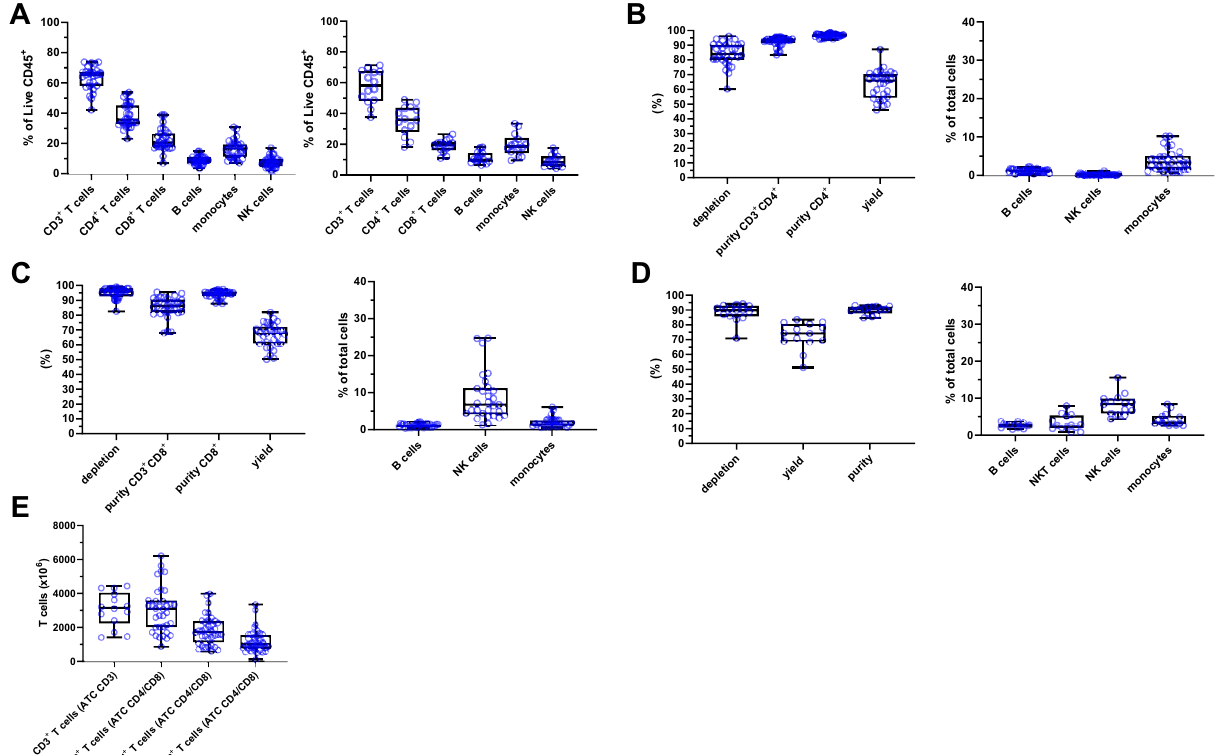
Figure 3. Characterization of ATC T cell purification using leukapheresis as starting material. ( A ) Lymphocyte cell subset composition of starting material. Graphs present data from 27 washed healthy apheresis donors (left panel) and washed cryopreserved apheresis healthy material from 14 donors (right panel). Boxes represent mean ± SD. ( B ) Selection data for CD4 target cell fraction in the ATC CD4/CD8 selection process. Graphs show CD4 + T cell depletion efficiency, purity for CD4 + T cell target fraction as well as CD4 + on-target fraction, CD4 T cell yield and on-target (monocytes) and off-target impurities (B cells, NK cells) of 27 individual purifications. Boxes represent mean ± SD. ( C ) Selection data for CD8 target cell fraction in the ATC CD4/CD8 selection process. Graphs show CD8 + T cell depletion efficiency, purity for CD8 + T cell target fraction as well as CD8 + on-target fraction, CD8 + T cell yield and on-target (NK cells) and off-target impurities (B cells, monocytes) of 27 selections. Boxes represent mean ± SD. ( D ) Selection data for CD3 target cell fraction in the ATC CD3 selection process. Graphs show CD3 + T cell depletion efficacy, purity for CD3 + T cell target fraction, CD3 + T cell yield and target fraction impurities (B cells, NK cells, monocytes) of 14 purifications. Boxes represent mean ± SD. ( E ) T cell purification data showing absolute target cell counts from the ATC CD4/CD8 process as well as ATC CD3 process. Graphs represent cumulative data described above. Boxes represent mean ±